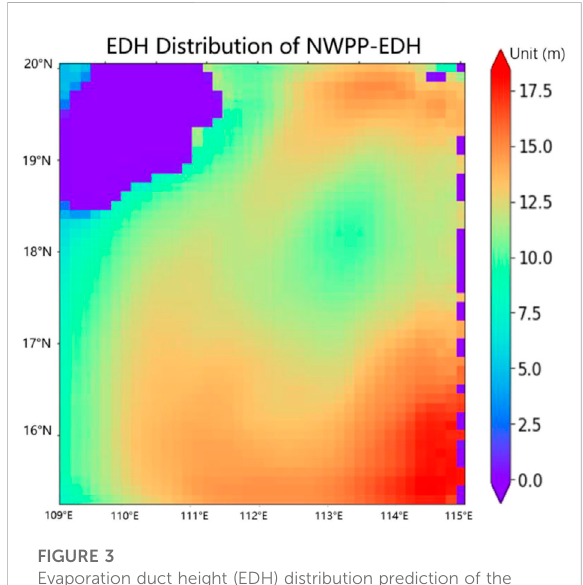
FIGURE 3 Evaporation duct height (EDH) distribution prediction of the NWPP-EDH